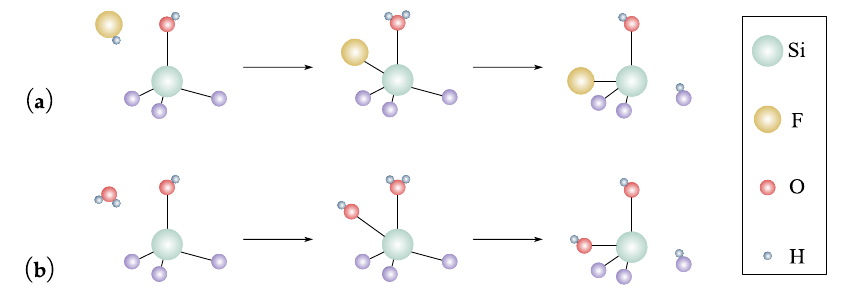
Figure 15. The schematic of reaction pathways of CARE with ( a ) HF; ( b ) pure water